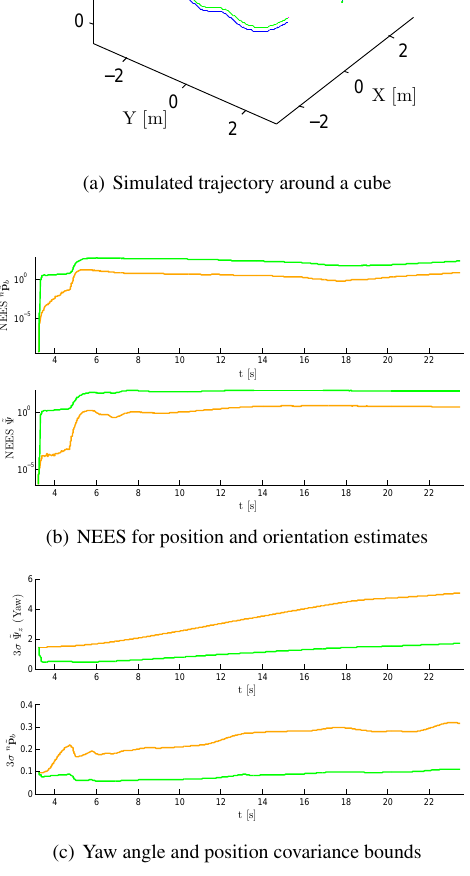
Figure 5: Cube sequence. See fig. 4 for